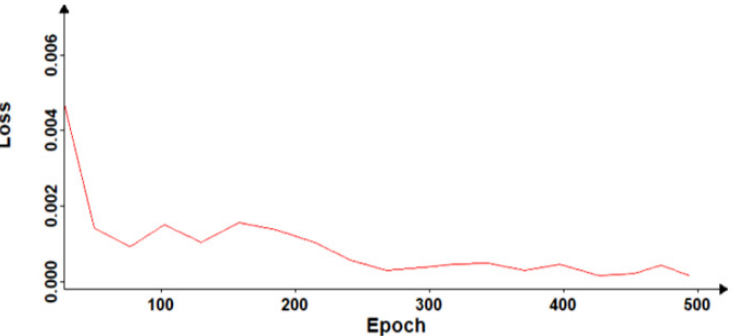
Figure 6. Loss variation of the adjusted convolutional neural networks with 6 Species.